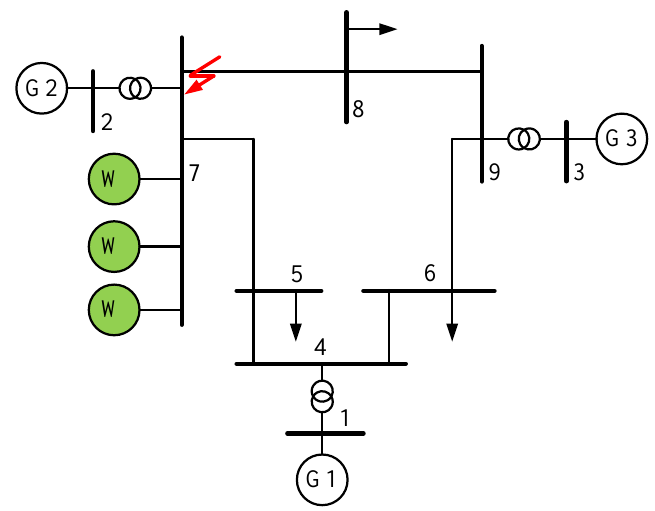
Figure 5. Western Systems Coordinating Council (WSCC) 3-machine-9-bus system integrated with PMSG-based wind farms.